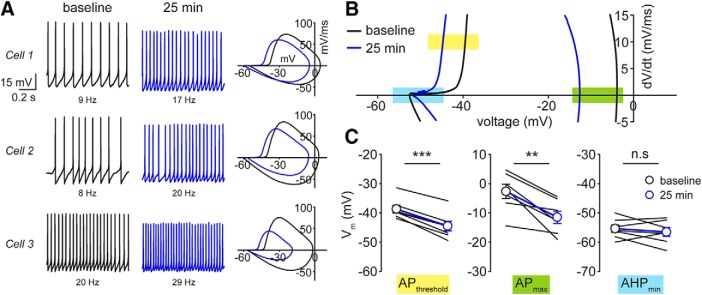
Defining the hallmark membrane features of SC excitability increase. A, left panels, Spontaneous AP firing traces from three example SCs at baseline (black) and after 25 min (blue; patch #150129p2, #181111p6, #181109p3). Right panels, AP cycles for each cell calculated from voltage-time data at baseline (black) and 25 min (blue). B, AP cycle plot of an example SC with y-axis expanded. Colored rectangles designate quantities of interest (yellow, AP threshold; green, AP maximum; light blue, AHP minimum). C, Summary comparison of these three features measured from individual AP cycles (n = 7 cells). *** denotes p < 0.001, ** denotes p < 0.01, n.s denotes p > 0.05.